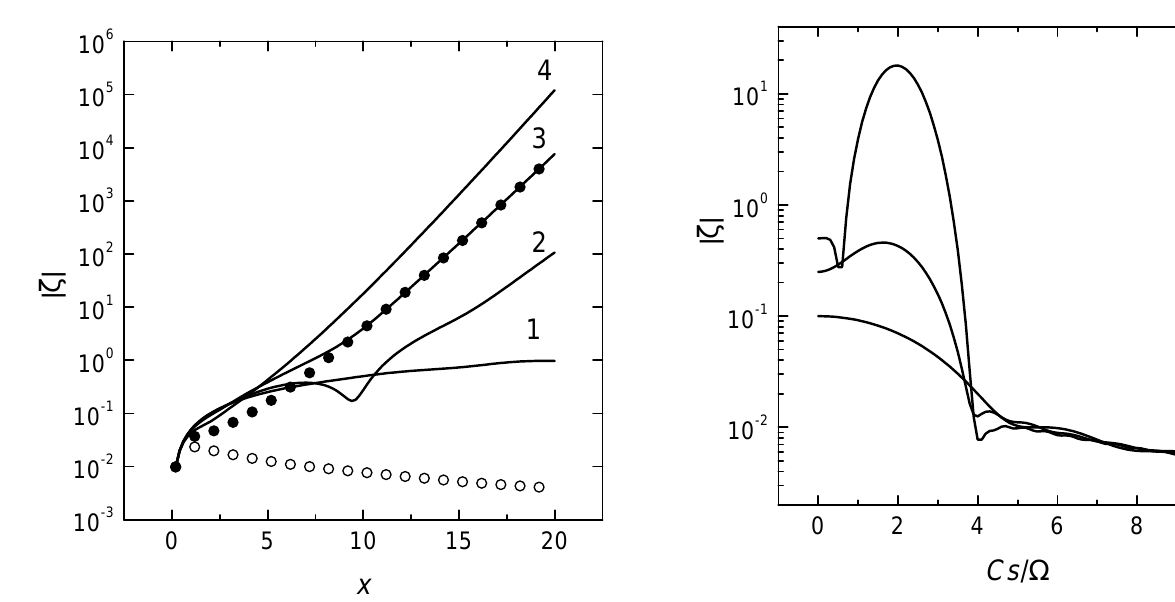
FIG. 5. Dependences of the (dimensionless) amplitude j z j on the distance along the beam. The total phase advance of the ion oscillations along the beam is (cid:76) V (cid:173) (cid:50)(cid:48) ; solid curves correspond to (1) (cid:116) (cid:173) (cid:67)(cid:115) (cid:121) V (cid:173) (cid:48)(cid:46)(cid:49) ; (2) (cid:116) (cid:173) (cid:48)(cid:46)(cid:53) ; (3) (cid:116) (cid:173) (cid:49) ;